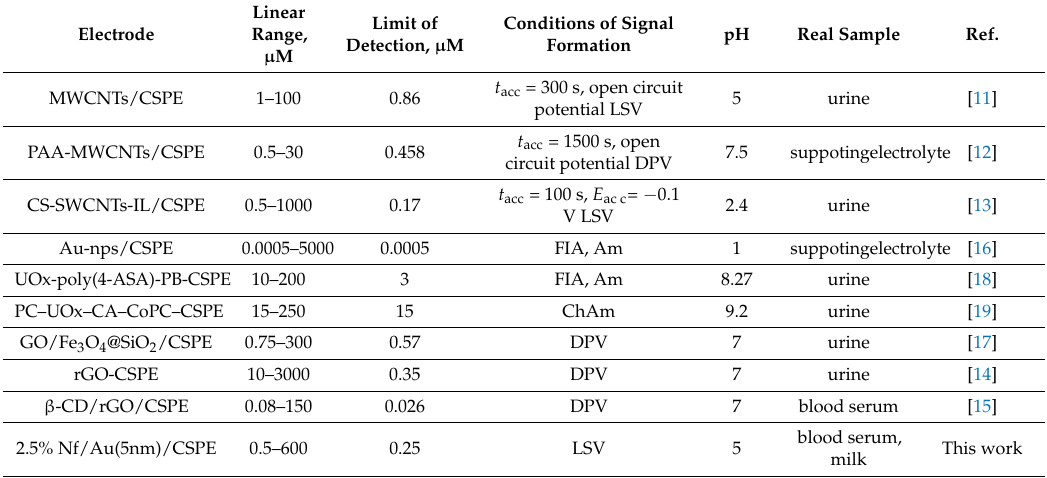
Table 3. Analytical characteristics of UA determination with the use of different modified